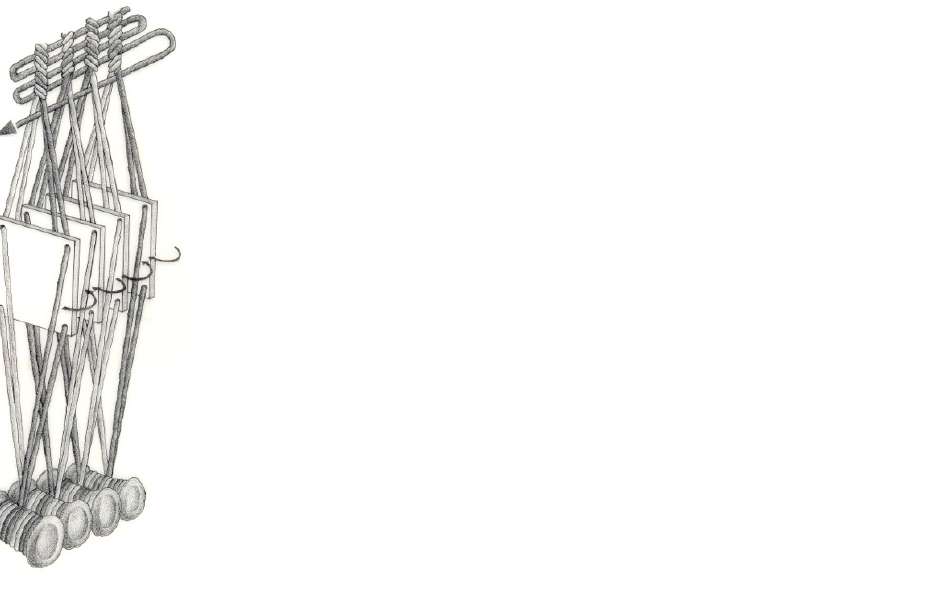
Figure 3. Illustration of tablet weaving utilizing rocchetti as weights (Image: Poggio Civitate Pro- ject).